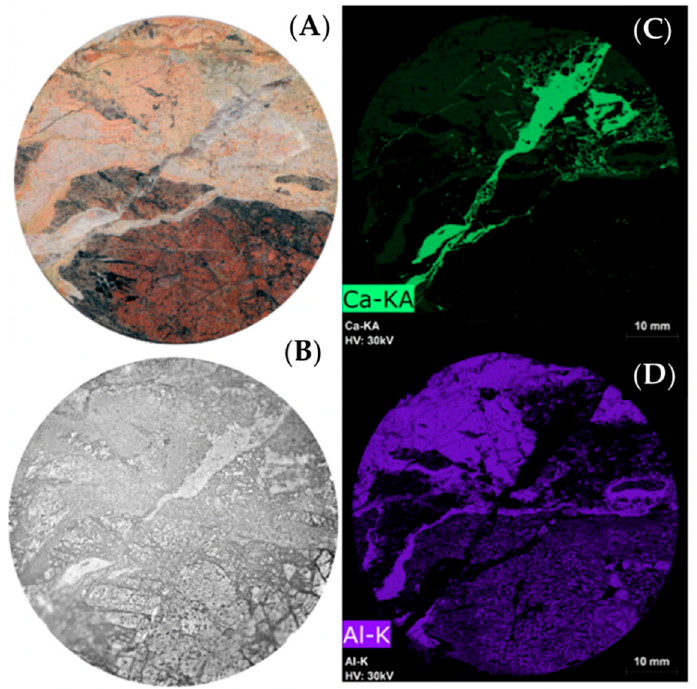
Figure 4. ( A ) optical image of sample R-11(disc (3)); ( B ) radiogram of americium sorption on sample R-11 (disc (3)); ( C ) elemental map of Ca distribution on the surface of R-11 sample (calcite identifying); ( D ) elemental map of Al distribution on the surface of R-11 sample (identifying of chlorite, epidote, feldspars, zeolite).